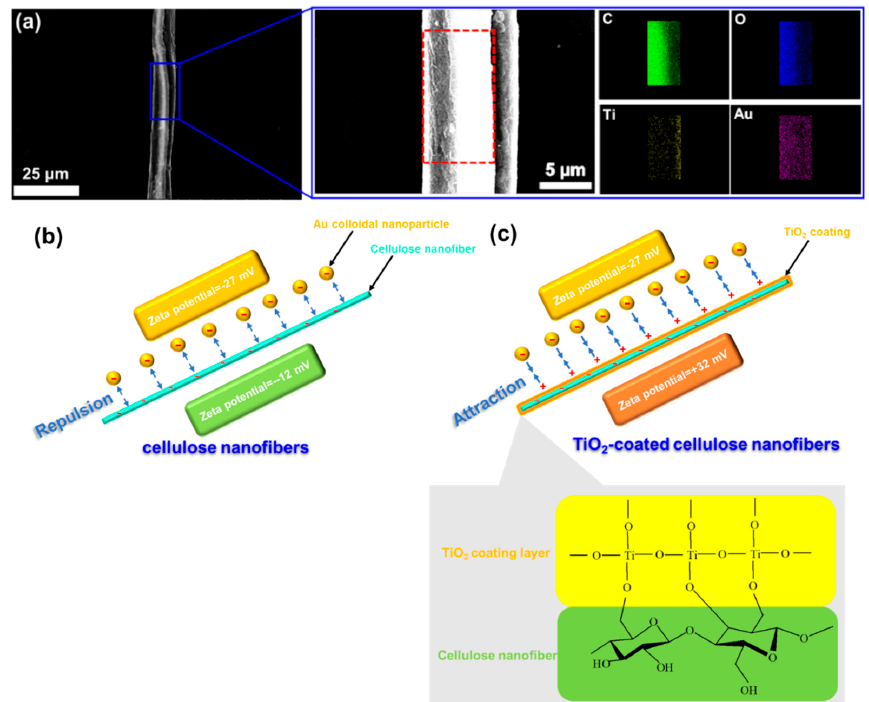
Figure 4. ( a ) FE-SEM micrograph of a single TiO 2 -coated cellulose nanofiber after filtrating Au colloidal suspension, with a locally enlarged FE-SEM image and EDX element mapping, ( b ) and ( c )